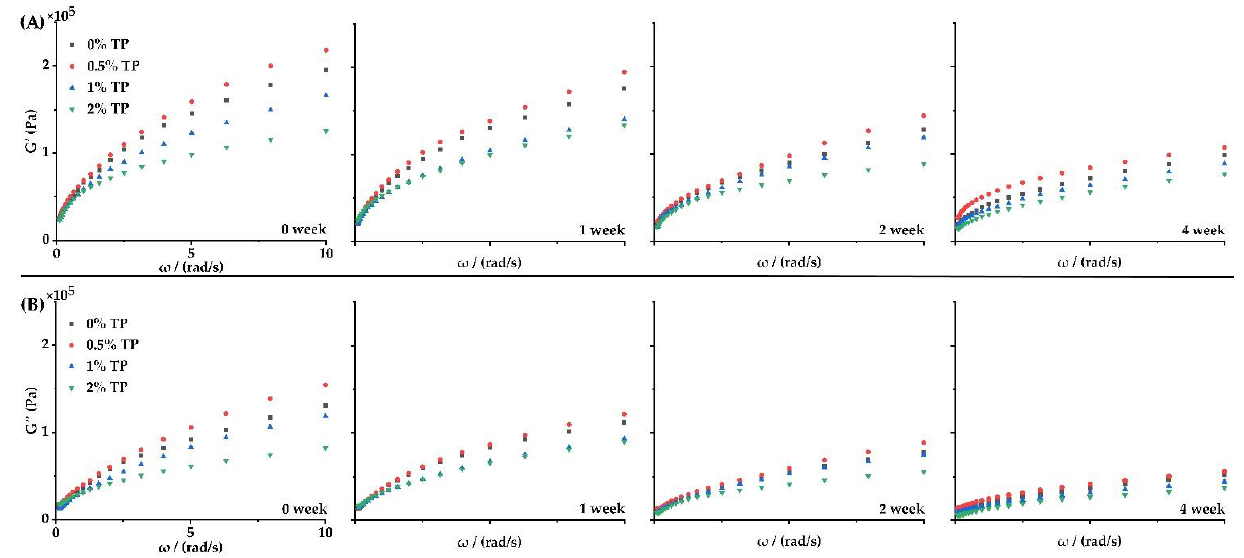
Figure 2. Effect of TPs on G′ ( A ) and G″ ( B ) of the NFFD (0.1 – 10 Hz frequency, 25 °C) at 0 – 4 weeks.